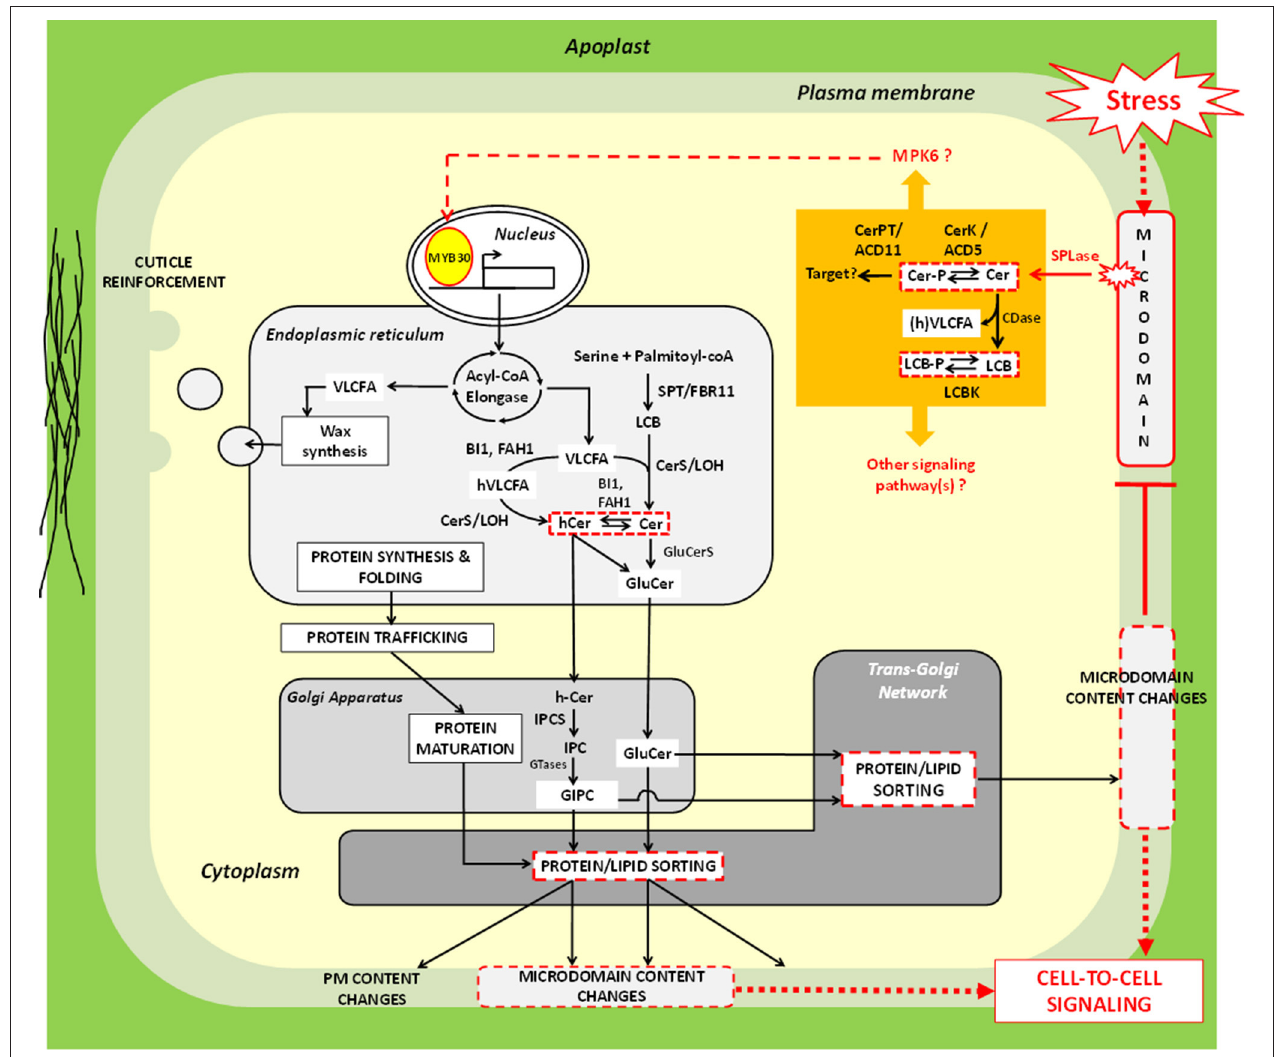
FIGURE 3 | Molecular model explaining how very-long-chain fatty acids could participate in stress signaling response in plant cells. In mammalian systems, extrinsic cues can be perceived at the plasma membrane by means of microdomains. A comparable hypothesis can be emitted for plant models. It is possible that “sphingolipase D” (SPLase) like the one identified by Tanaka et al. (2013) is recruited to microdomains following stress exposure, and releases ceramide (Cer) molecules from complex glycosphingolipids in situ . Free Cer could either directly act as signals or be processed into Cer-P by the kinase ACCELERATED CELL